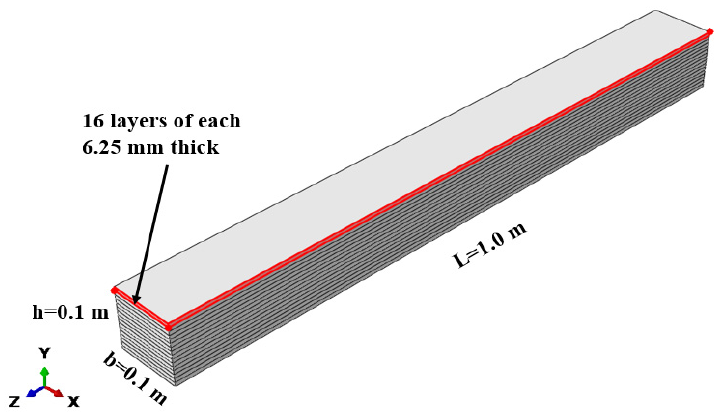
Figure 5. Numerical modeling of FGM beam in ABAQUS.